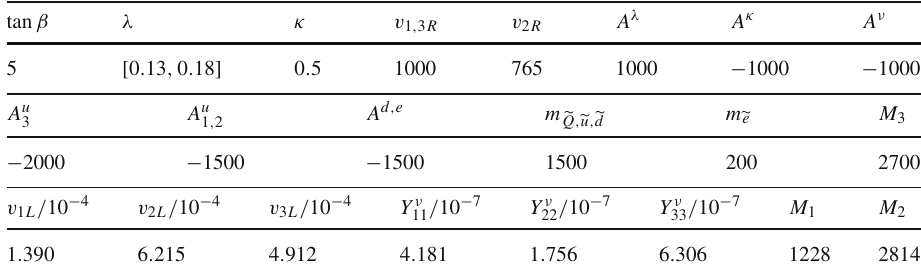
Table 2 Low-energy values for the parameters, as defined in the text, of the scan over λ